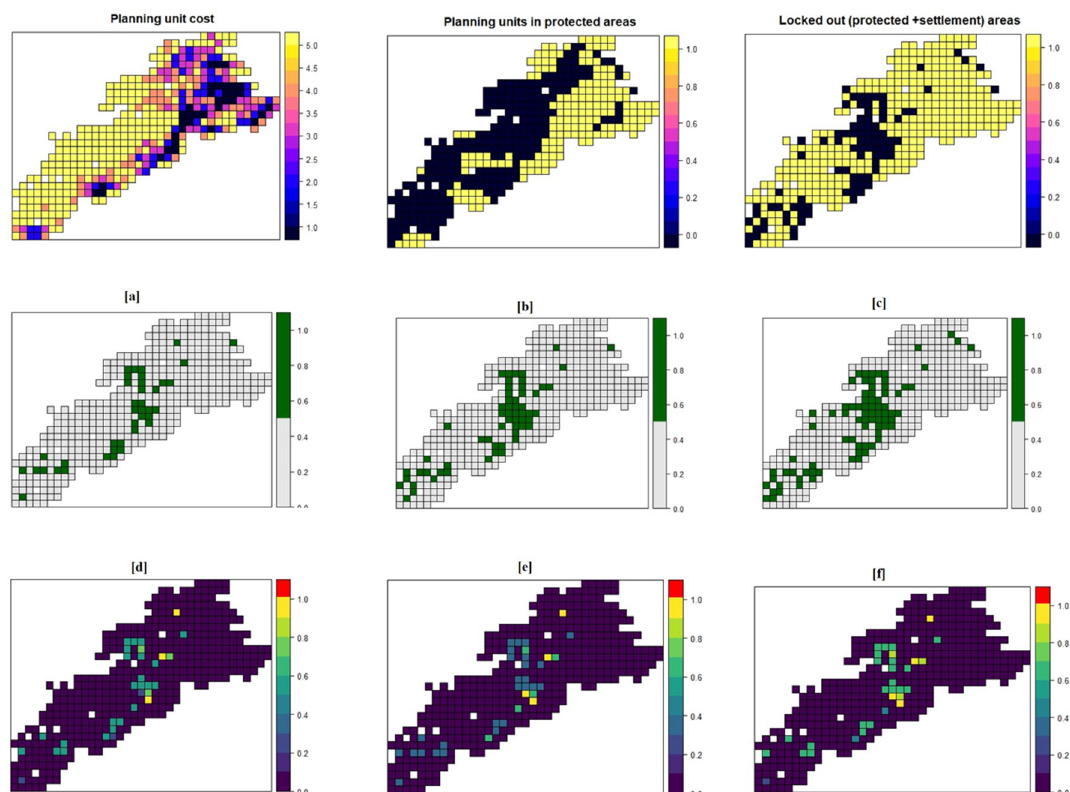
Figure 4. Proposed conservation planning units (4 km × 4 km grids) in the high potential gibbon habitat of upper Brahmaputra Valley, Assam, India (prepared in prioritizr R package, Rstudio platform 43 ). All protected areas are excluded from the grid map as those are already under prioritized category. Settlement percentage was calculated for each grid cell and the grids having more than 30% settlement land use were excluded from the analysis: ( a ) to protect 10% of gibbons’ habitat; ( b ) to protect 15% of gibbons’ habitat; ( c ) to protect 20% of gibbons’ habitat; ( d ); ( e ) and ( f ) shows irreplaceability of the proposed units to conserve 10%, 15% and 20% gibbons’ habitat respectively (higher the value, more is the irreplaceability; planning replaceable units are shown in purple, blue, green, and yellow colours, and truly irreplaceable planning units are shown in red Pradesh, India. Moreover, extirpation of gibbons and other coexisting primates from several small fragments of the upper Brahmaputra Valley 16,23,44,51 demand further study of localized specific habitat needs of the primates in general, particularly mating and dispersal requirements. The decreasing trend of forest cover within the high potential habitat of gibbons in the study region over the last two decades and the higher percentage of agriculture in the same habitat zone highlights the intrusive presence of agricultural matrix in gibbon’s habitat. Sarma et al. 52 also recorded the presence of agricultural land within the potential habitat of the eastern hoolock gibbon in Arunachal Pradesh. As the intrusion of agricultural lands creates fragments, it becomes more difficult for the species to explore all the resources available in different forest patches. Therefore, in the long run, the population health is likely to deteriorate. Nonetheless, the two species of gibbons found in northeast India are reported to occur in forests of variable gradients in terms of quality and structure, and the present study is consistent with several such studies 16,17,20,21,23,44,47 . The present study also confirmed that the highest percentage area of dense forest was found in the high potential habitat zone of gibbons. We note that tea plantation is a key driver that affects the NDVI map of the study area, as tea plantations are classified under dense forest categories. Since we have omit- ted the tea plantation area from the dense forest category by testing the output map with ground data, the high potential habitat zone still represents the maximum dense forest area even if the tea plantation area is removed. The canopy cover change of the study area in the last decade (2008–2018) carries a pessimistic outlook due to the high change in the very dense canopy. Chronological conversion from very dense canopy to dense canopy, dense canopy to open canopy, and open canopy to no canopy might be the result of canopy senescence, and decrease in tree density driven by increasing settlements. Conversely, an increase in canopy cover was also observed, probably due to canopy growth and vegetation succession, which showed area conversion from no canopy to open canopy (724.3 km 2 ), open canopy to dense canopy (828.3 km 2 ), and dense canopy to very dense forest (199.3 km 2 ). While the present study shows minimal conversion of very dense canopy to open canopy (2.4 km 2 ), it is of serious concern to the survival of gibbons given the habitat suitability of the study area. Although the increase in the area of very dense canopy (141.3 km 2 ) within the high potential zone of gibbons over the last decade is encouraging, it is equally important to investigate the precise locations where the canopy has improved.